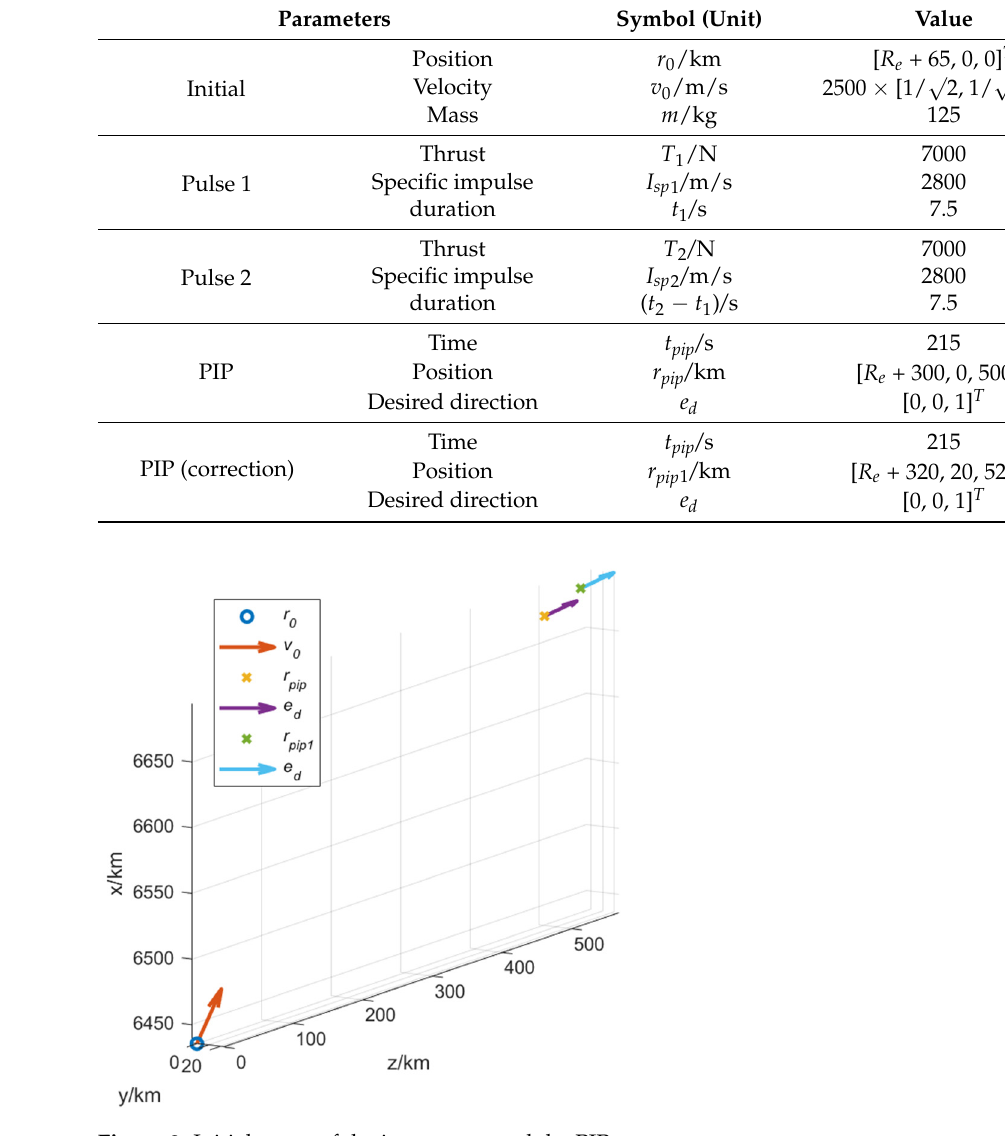
Figure 2. Initial states of the interceptor and the PIP.